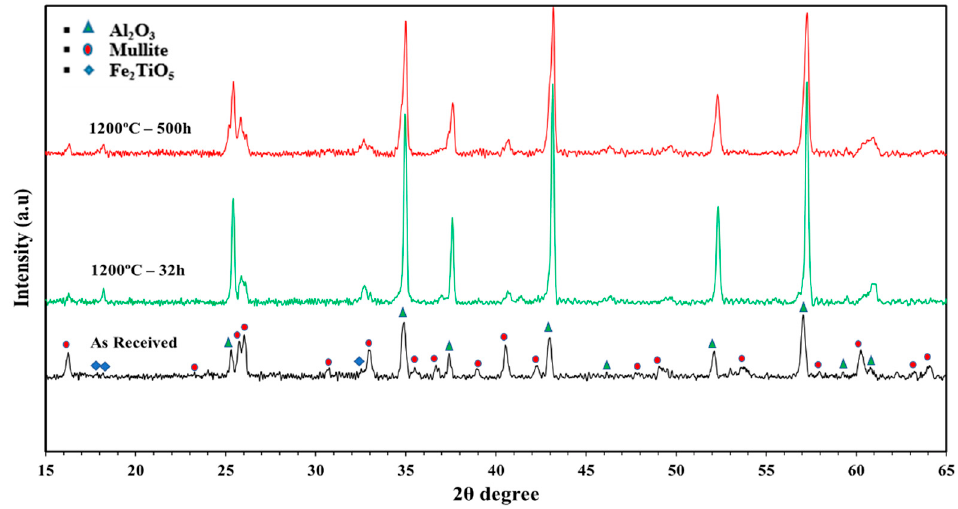
Figure 8. XRD data for CARBOBEAD CP in the “as received” condition and following heating in air at 1200 °C for different periods. Symbols correspond to the following phases. Table 6. Elemental composition of CARBOBEAD CP.